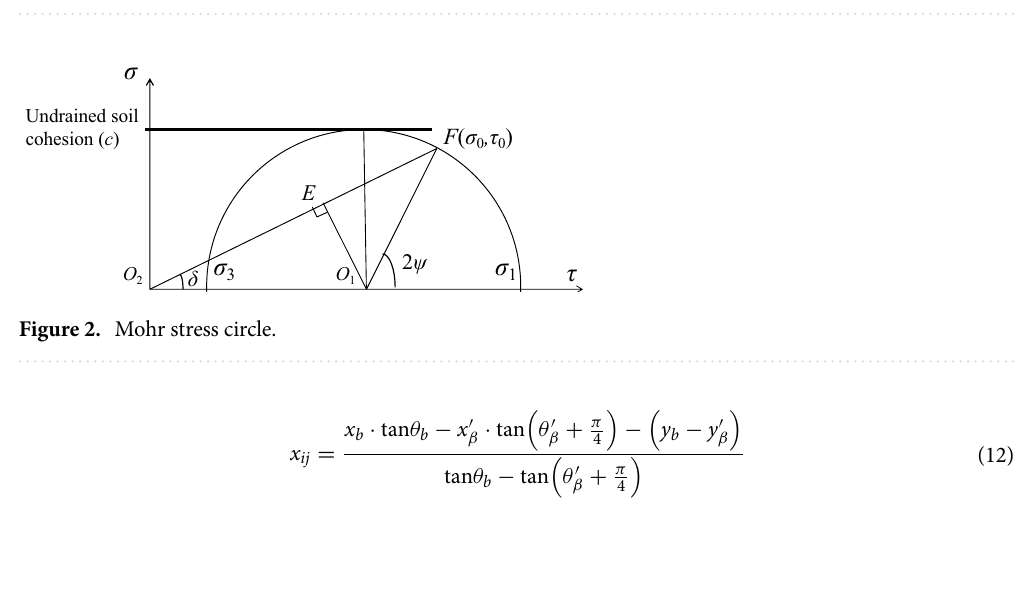
Figure 1. The undrained method of characteristics: ( a ) diagram of slip line field; ( b ) Cauchy boundary schematic; ( c ) degenerative Riemann boundary schematic; ( d ) mixed boundary schematic.